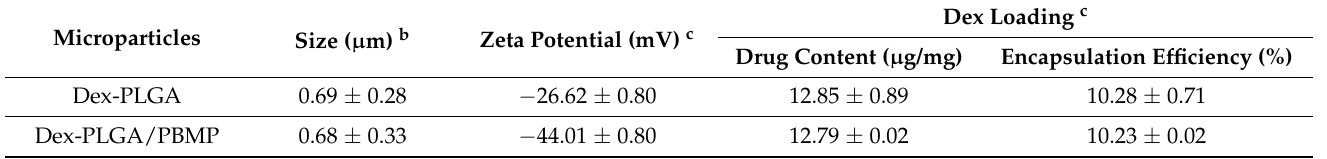
( c ) Figure 3. Enhancement of the HA-binding affinity of PLGA particles by PBMP coating. The repre- sentative CLSM images of the HA discs after incubation with Cy5.5-loaded ( a ) PLGA or ( b ) PLGA/PBMP particles, respectively. Red fluorescence indicates the position of particles. Each scale bar represents 100 μm. ( c ) Comparison of fluorescence intensities in the CLSM images. The fluores- cence intensity was measured in randomly selected areas of each HA disc ( n = 12). The bar represents the mean ± SEM. The statistical analysis was performed using Student’s unpaired t -test. *** indicates p < 0.001. 3.4. In Vitro Drug Release of Dex-Loaded PLGA/PBMP Microparticles In vitro release of Dex from the PLGA/PBMP microparticles was examined by HPLC (Figure S2, Supporting Information). There is an initial burst up to 38% within 1 h. Then, the release was slowed down with the cumulative release of ~50% for 1 day. The Dex release continued at a slower rate. At the time point of the 7th day, the cumulative Dex release was approximately 70%. The sustained release of Dex was maintained over 7 days in the PLGA/PBMP microparticle system.